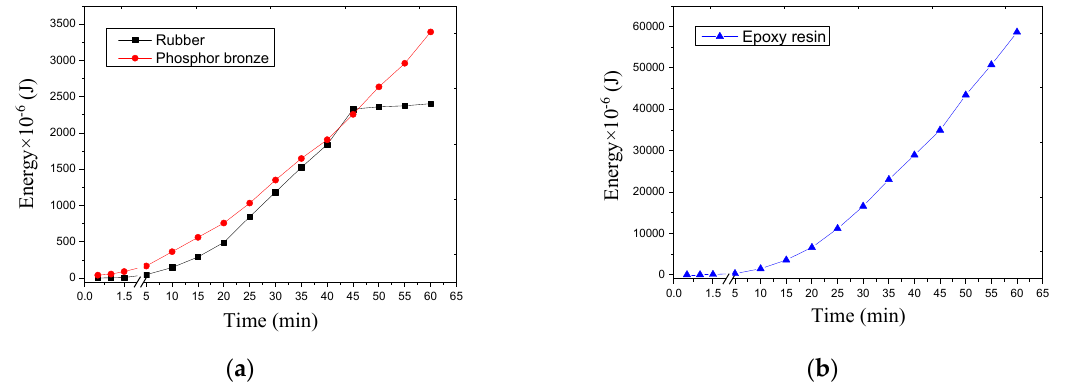
Figure 12. Energy collected by different materials. ( a ) rubber and phosphor bronze; and ( b ) epoxy